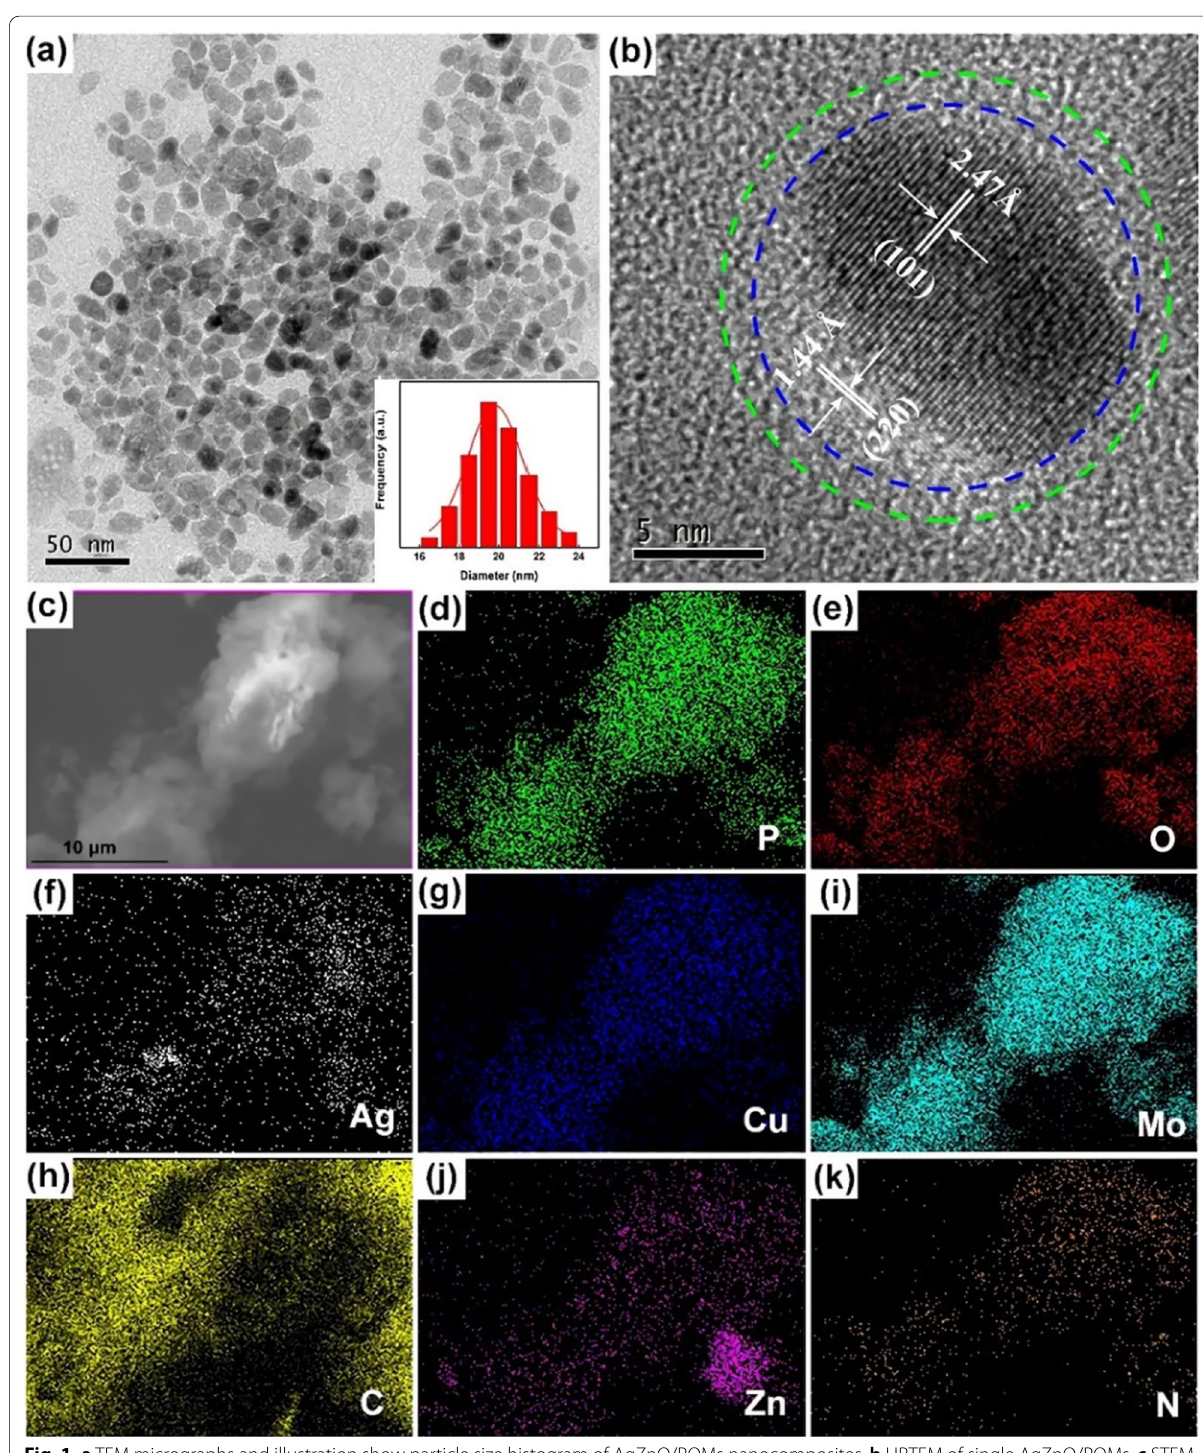
Fig. 1 a TEM micrographs and illustration show particle size histogram of AgZnO/POMs nanocomposites, b HRTEM of single AgZnO/POMs, c STEM micrographs and d – k corresponding elemental mappings of AgZnO/POMs